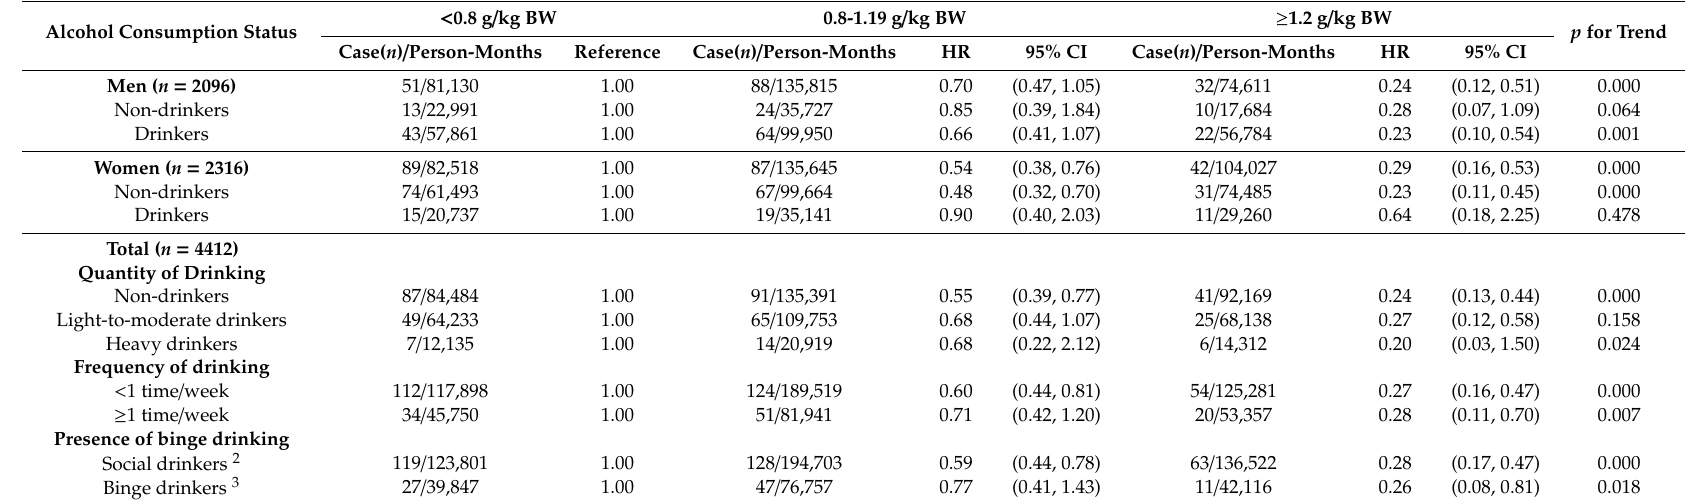
Table 2. Hazard ratios (HRs) and 95% confidence intervals (95% CIs) for the risk of developing low SMI by the levels of dietary protein intake at baseline according to alcohol consumption 1